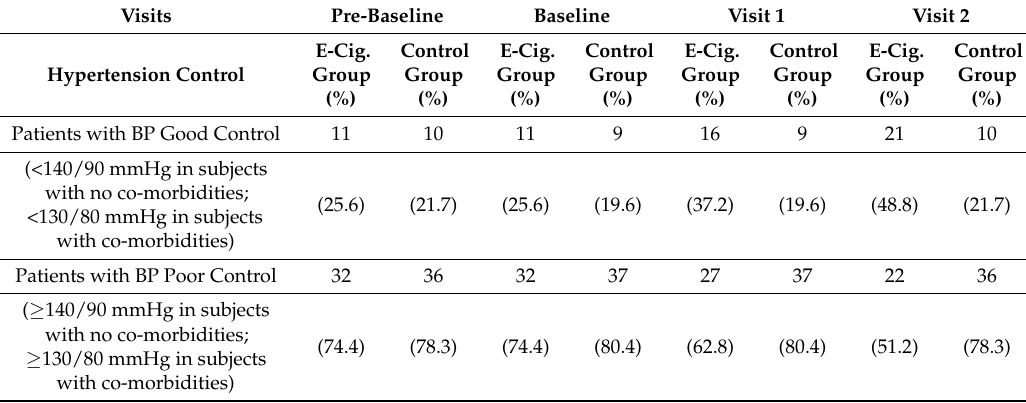
Table 4. Changes in Hypertension Control over time in the E-Cigarette ( n = 43) and Control Groups ( n =